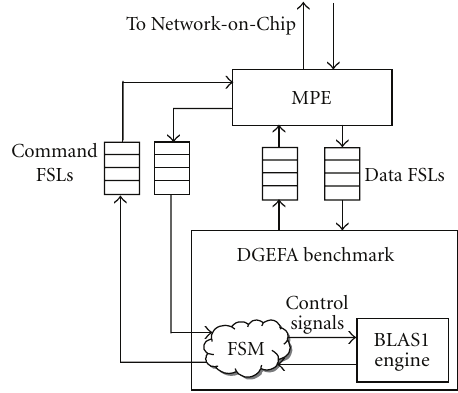
Figure 8: Interface between MPE and hardware